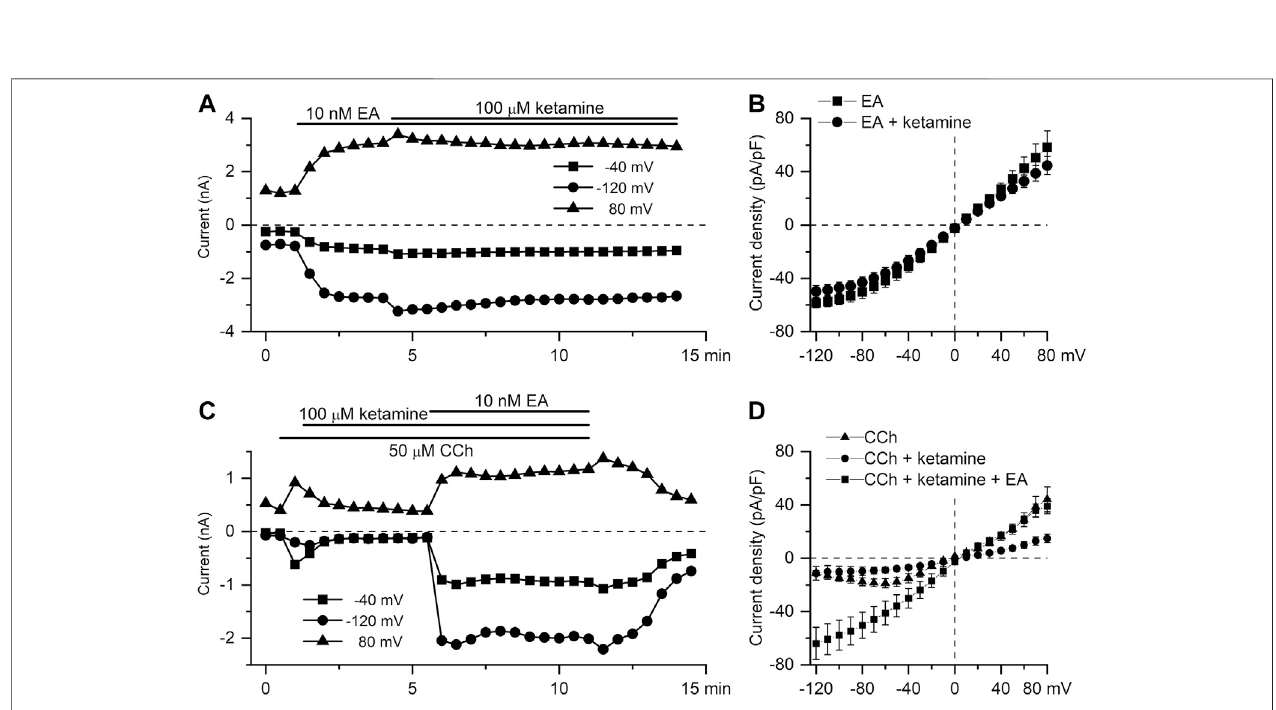
FIGURE 5 | EA-induced TRPC4 current is insensitive to ketamine. (A) Time course of TRPC4 current evoked by EA (10 nM) at three different test potentials, as indicated, showing the lack of the inhibitory action of ketamine applied at 100 μ M. (B) Mean steady-state I – V relationships of EA-induced current (10 nM) in control (squares, n (cid:2) 5) and in the presence of ketamine (100 μ M) (circles, n (cid:2) 5). (C) EA applied at 10 nM recovers mI CAT activated by the application of CCh (50 µM) and then suppressed by ketamine (100 µM). (D) Mean steady-state I – V relationships of CCh-induced current (50 μ M) in control, in the presence of ketamine (100 μ M) and after application of EA, as indicated ( n (cid:2)